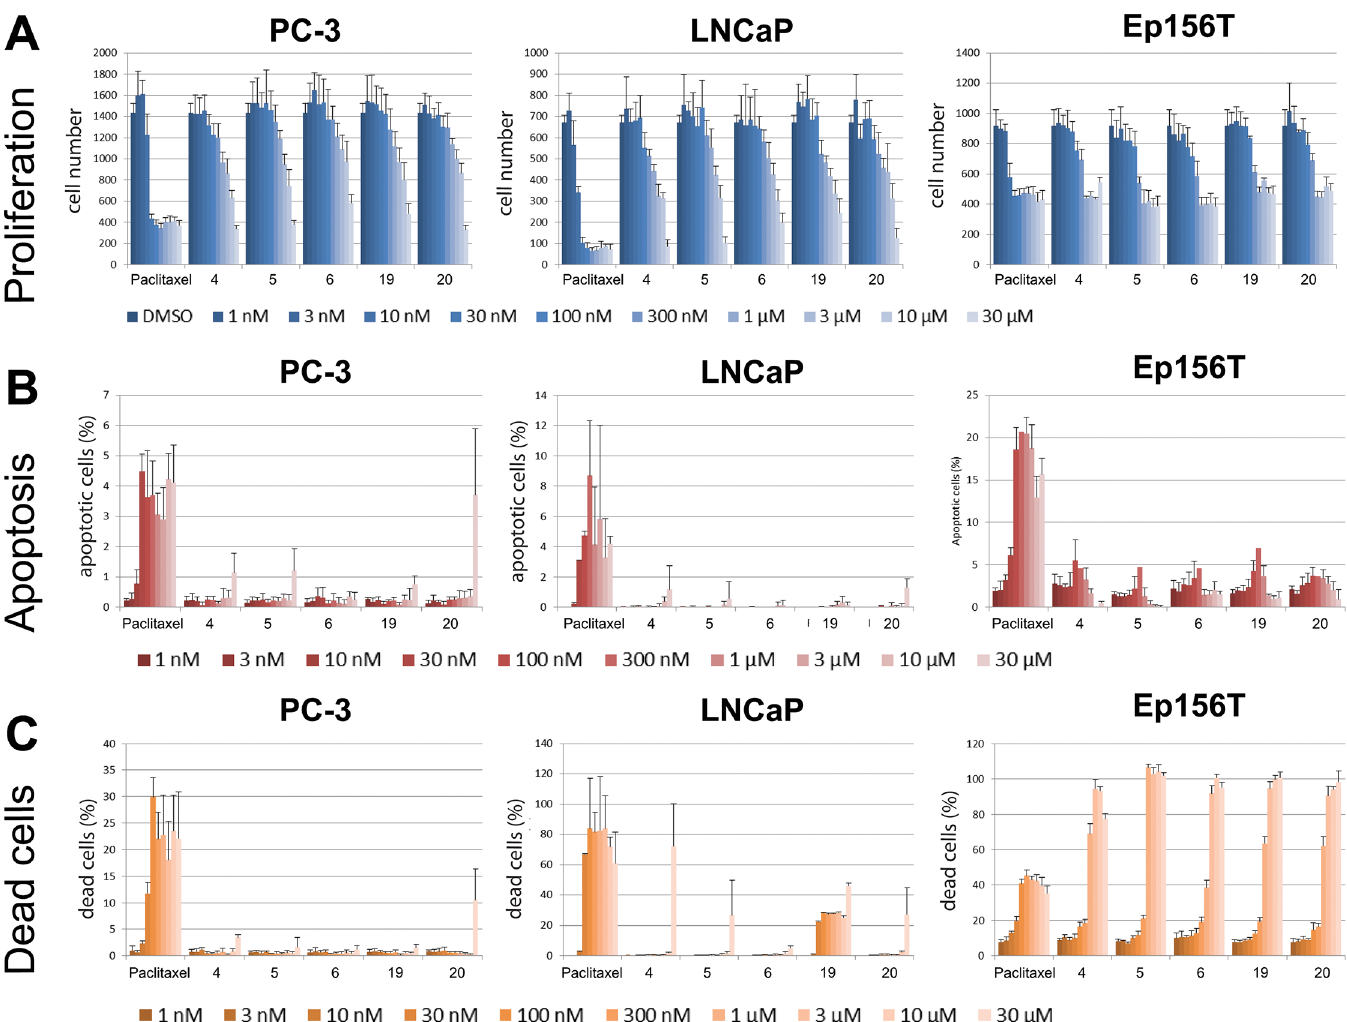
Fig 6. Cytotoxicity tests performed in 2D monolayer culture. A ) Cell proliferation/cell number, B ) programmed cell death (apoptosis), and C ) number of dead cells were assessed by conventional assays, combined with high-content microscopy (Operetta). Cells were treated with the five most effective betulin derivatives, including paclitaxel control for 72h. Proliferation was measured as the total number of nuclei (= cells), apoptosis as ratio of caspase-3 positive versus all cells, and cell death as ethidium homodimer-2 positive nuclei versus all cells.